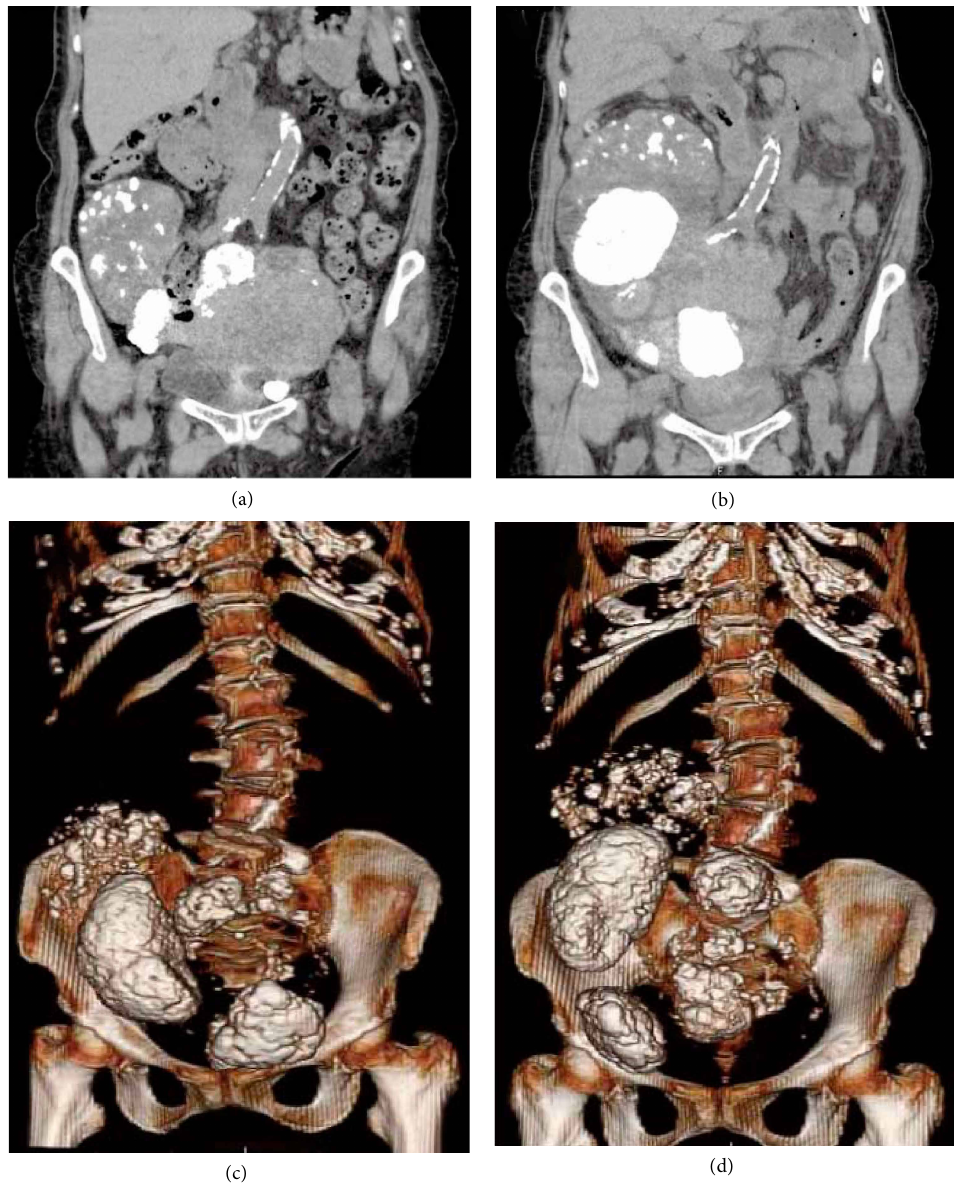
Figure 1: Computed tomography (CT) findings of the myomatous uterus. (a) Coronal section of the abdomen one year before the uterine torsion. The myomatous uterus and calcified portion are observed. (b) Coronal section of the abdomen at the time of uterine torsion. The myomatous uterus significantly increased in size, and the calcified lesion was displaced. (c) Three-dimensional reconstruction images of the lower abdomen one year before the uterine torsion. (d) Three-dimensional reconstruction images of the lower abdomen at the time of uterine torsion. The calcified area inside the uterus was largely